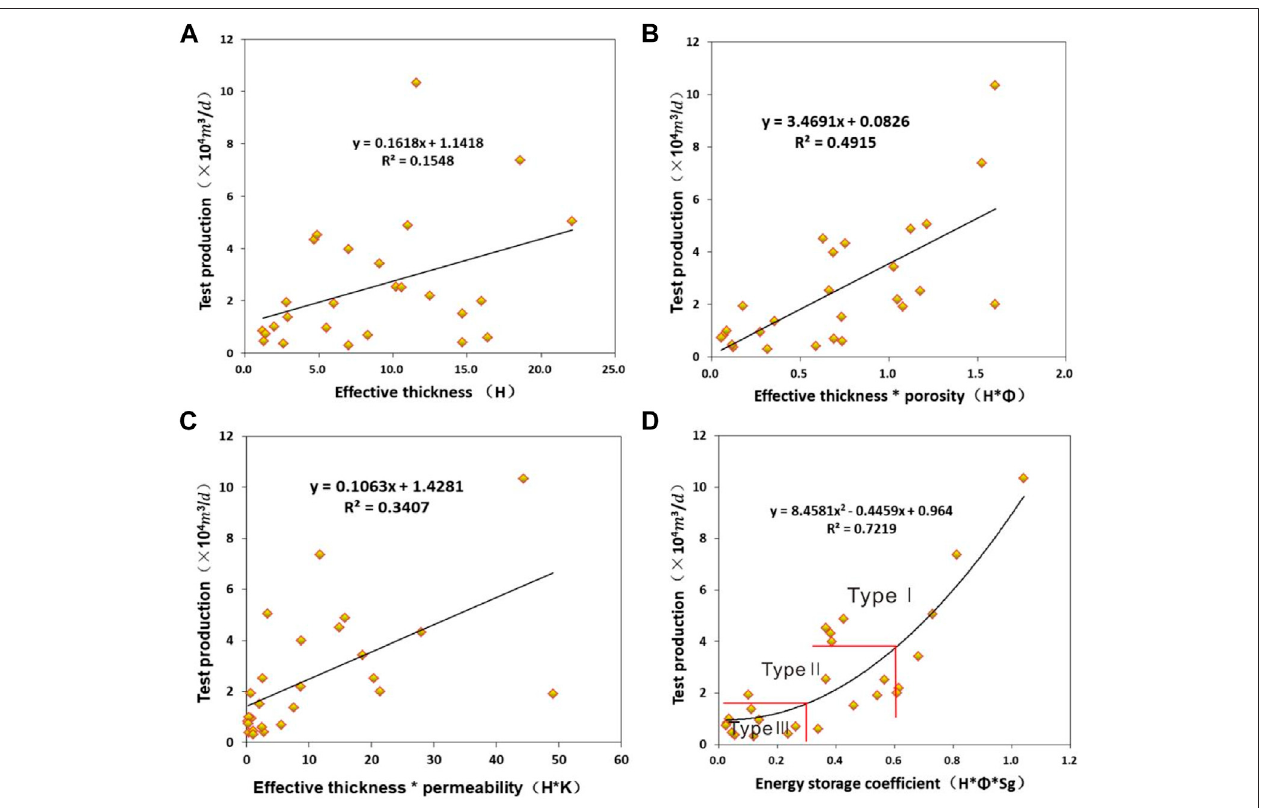
FIGURE 6 | Relationship between sensitive parameters and productivity of volcanic reservoir in the Wangfu gas fi eld. Note: (A) Relationship between the effective thickness and production capacity, (B) relationship between effective thickness * porosity and productivity, (C) relationship between the formation coef fi cient and productivity; and (D) relationship between the energy storage coef fi cient and productivity.